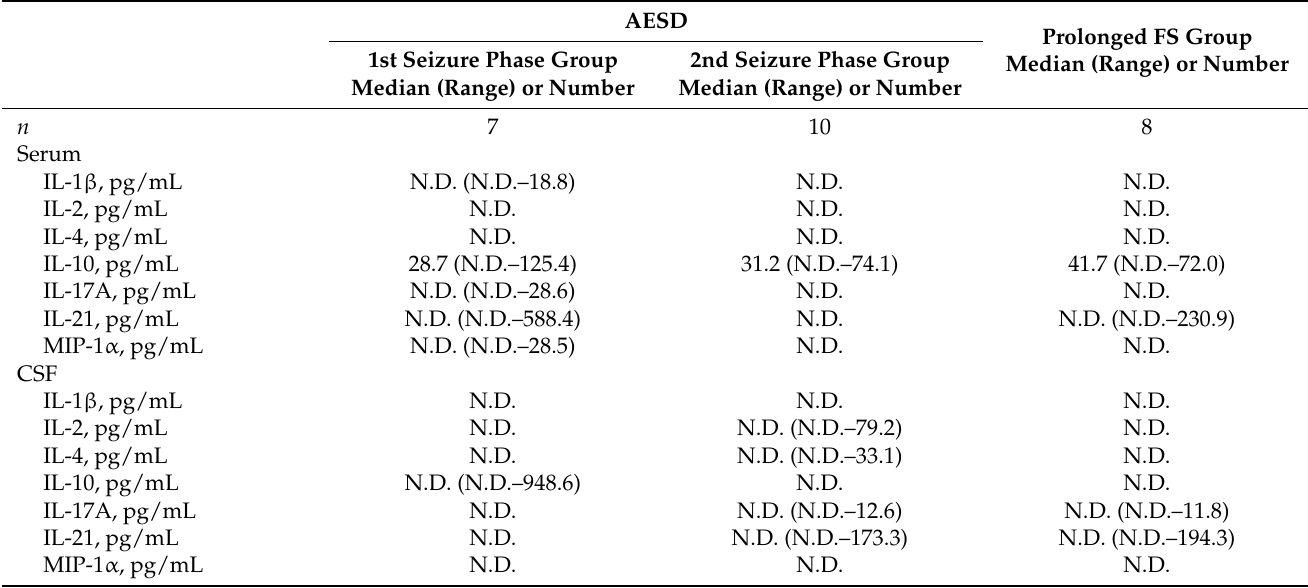
A positive correlation was observed between serum concentrations of MMP-9 and TIMP-1 ( p < 0.05, Rs = 0.474) (Figure 3A), whereas no interaction was detected by a group- based analysis (Figure 3B–D).